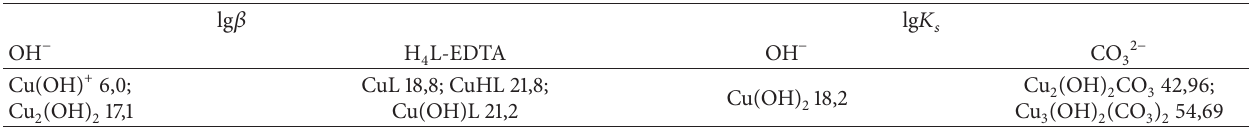
Figure 3: The forms of U(VI) (a) and Cu(II) (b) in aqueous solution in the presence of carbonate ions. 𝐶 ( 10 −4 M. Table 1: The general stability constants of complex compounds (lg 𝛽 ) and sediment (lg 𝐾 𝑠 ) formed by sparingly soluble salts and complexes of copper (lg 𝐾 𝑠 ) ( 𝐼 = 0